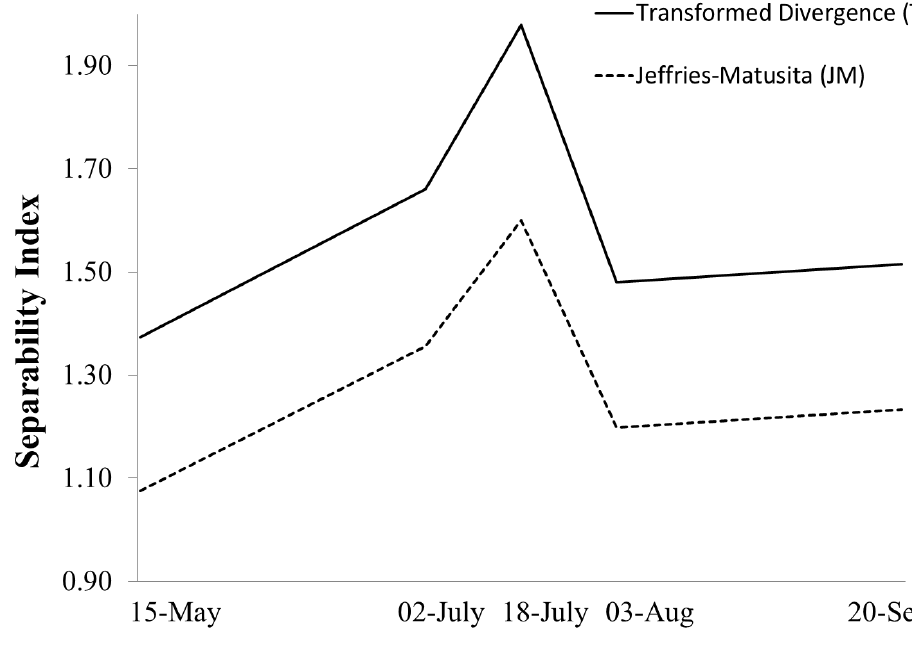
Figure 3. Measures of separability obtained from individual scene dates in 2007 (15 May, 2 July, 18 July, 3 August and 20 September) between pairs of basalt and non-basalt reference data. Values greater than 1.9 are considered to have good separability for